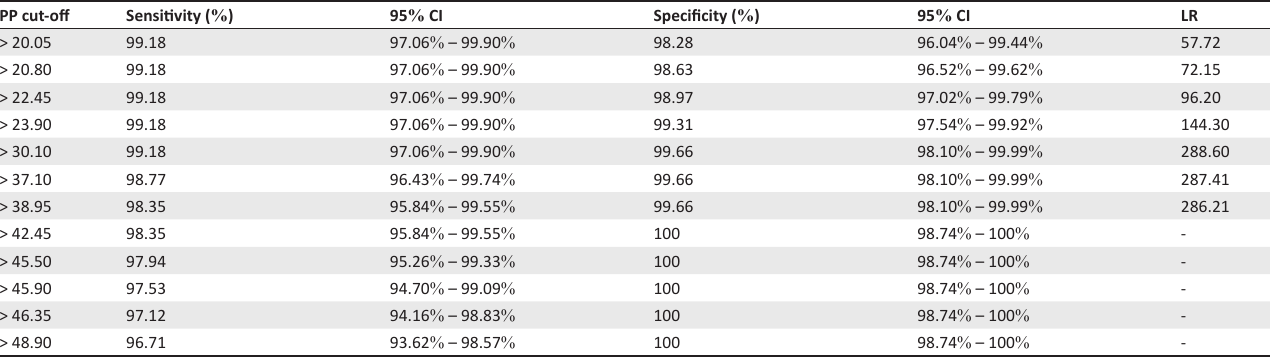
TABLE 1: Receiver operating characteristic curve analysis of the double-antigen ELISA.